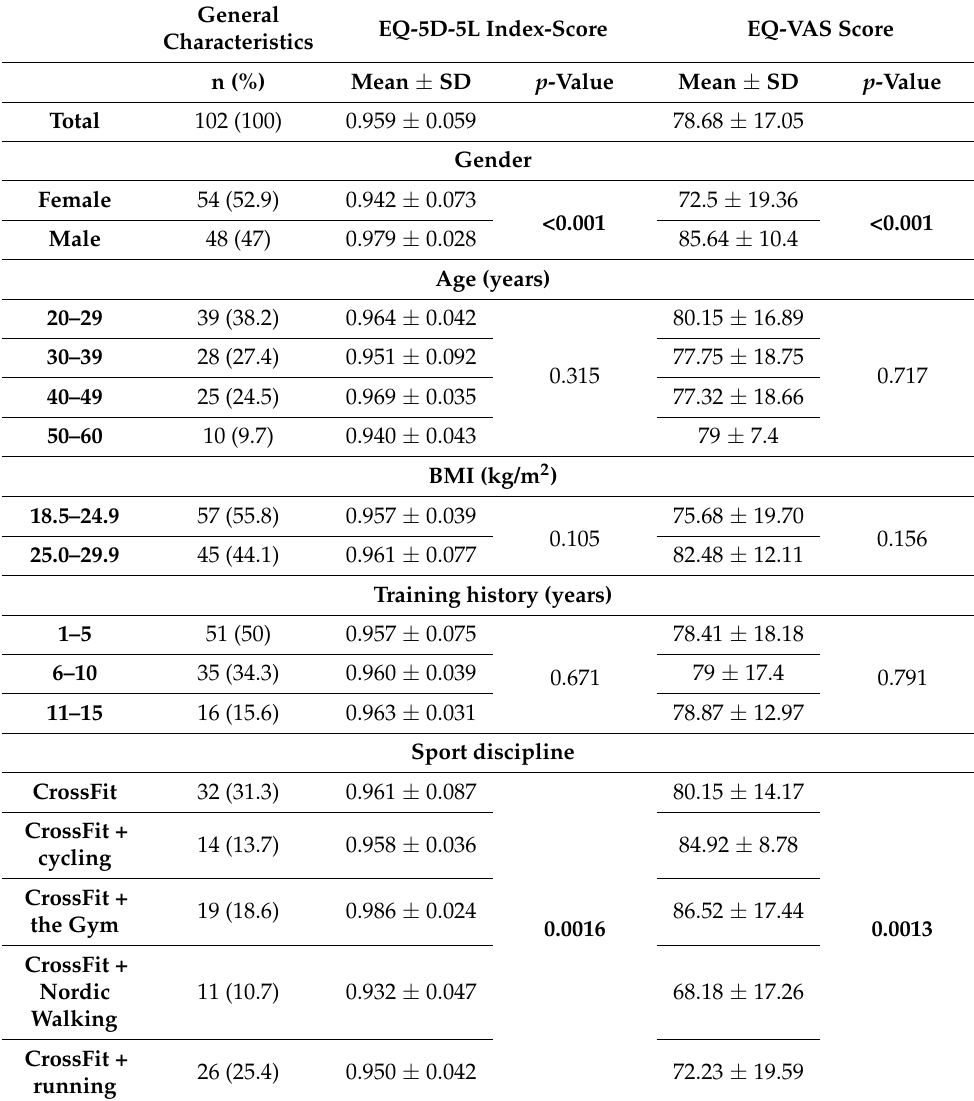
Table 1. The results of the assessment of the quality of life according to the EQ-5D-5L index and EQ-VAS questionnaire with the statistical